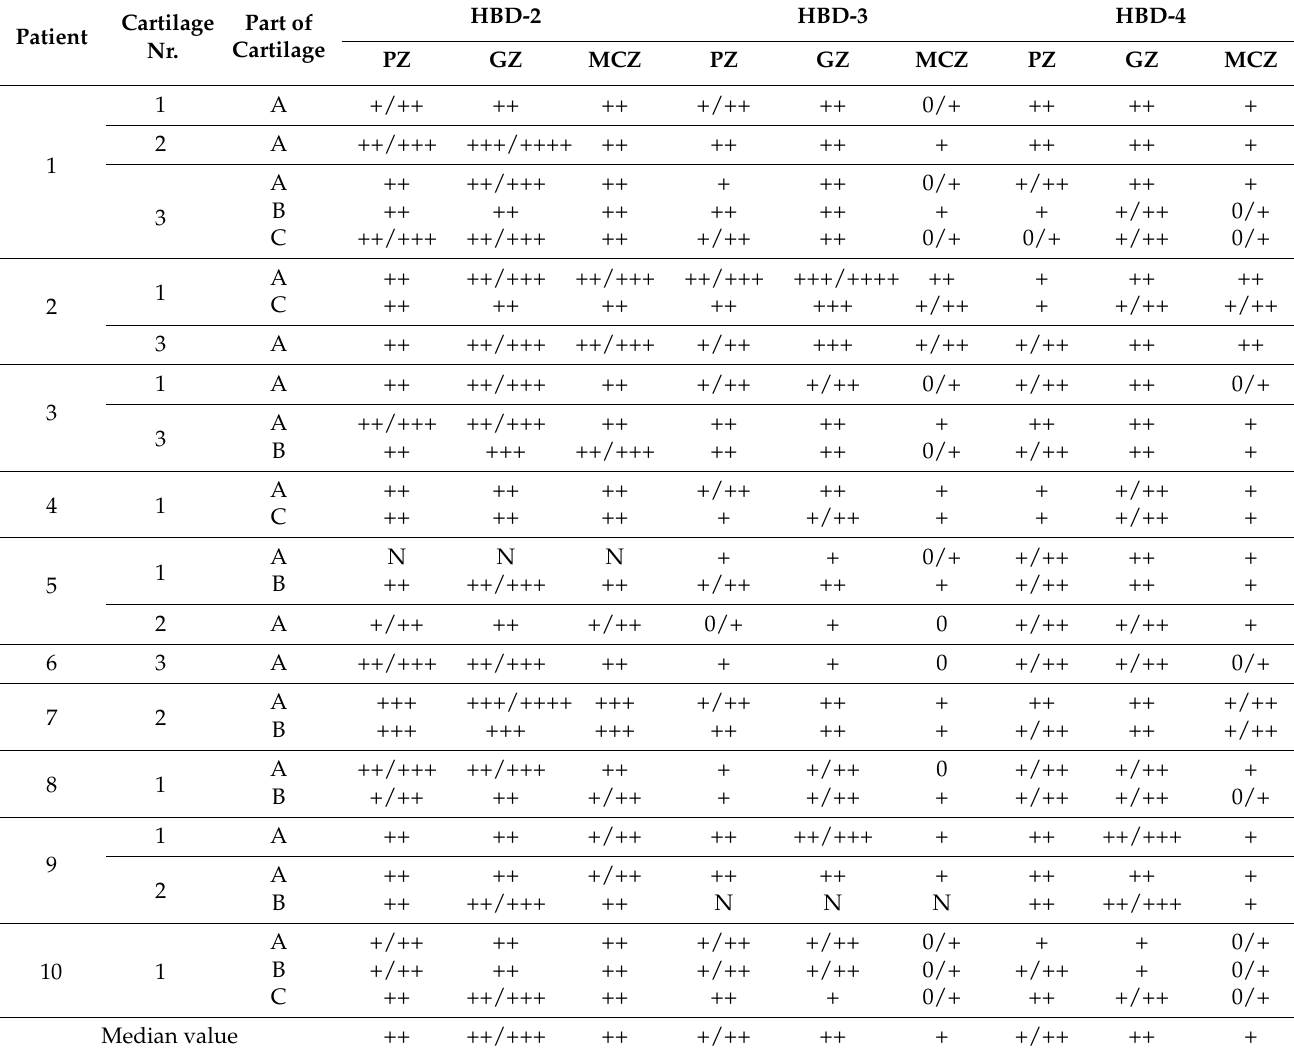
Table 3. Relative number of human beta defensin positive cells in different tracheal hyaline cartilage